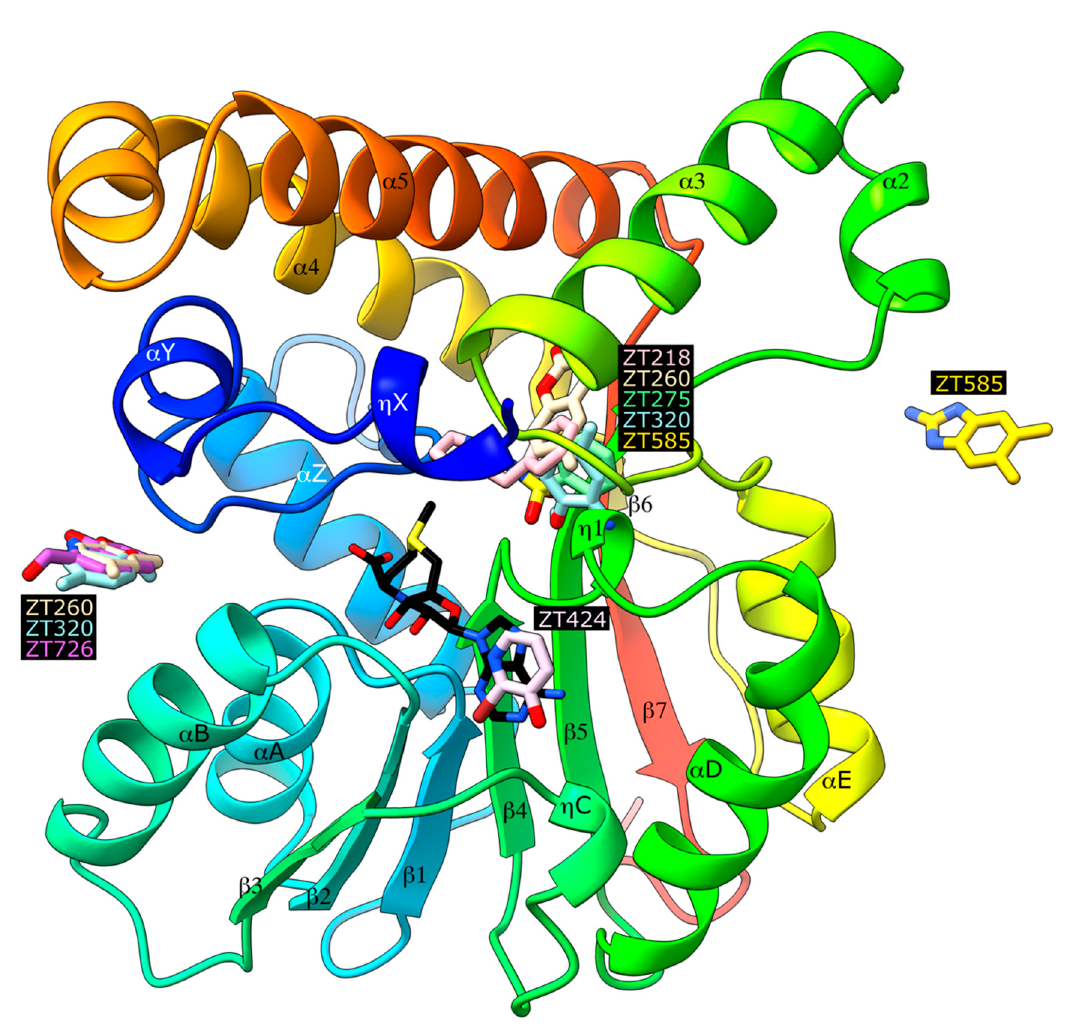
Figure 2. Ribbon representation of the Hma protein (PDB ID 2FK8) in the presence of the S-adenosylmethionine cofactor, represented as sticks with black carbon atoms, with all observed bound fragments represented as sticks with coloured carbon atoms. The protein is represented as a ribbon coloured from blue at the N-terminus to red at the C-terminus and secondary structure elements are labelled according to [30].